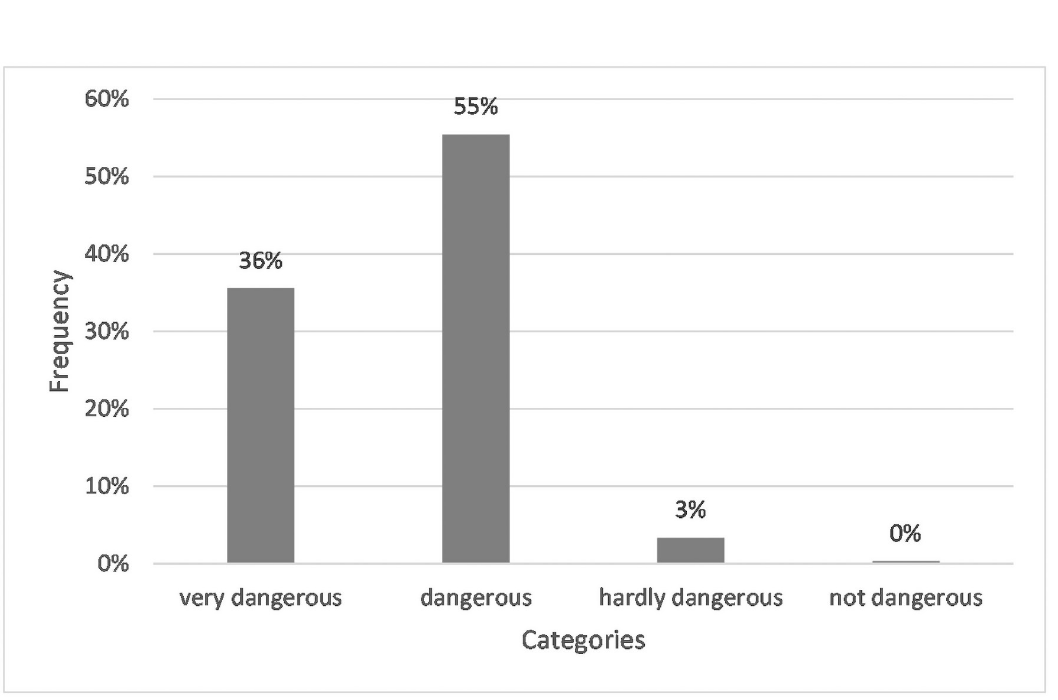
Fig 2. Frequencies of students whose answers assigned to the corresponding categories for Q5a: “Assess the potential danger posed by microplastics. (a) very dangerous, (b) dangerous, (c) hardly dangerous, (d) not dangerous.” N = 267. Closed question with predetermined